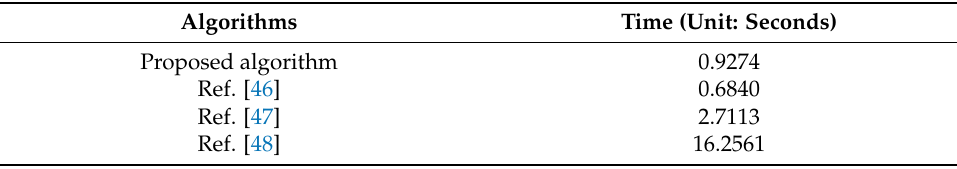
Table 12. Encryption time and comparisons (512 × 512 8BPP